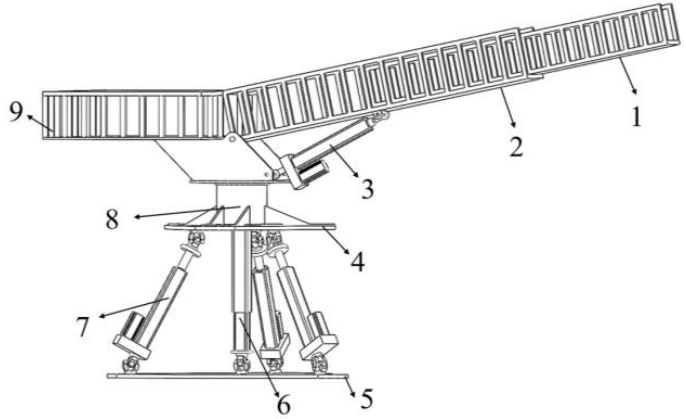
Figure 1. Structural components of the offshore gangway: 1—telescopic arm; 2—main arm; 3—pitching motor; 4—fixed platform; 5—moving platform; 6—follower branch chain; 7—drive support chains; 8—slewing mechanism; 9—transfer platform.